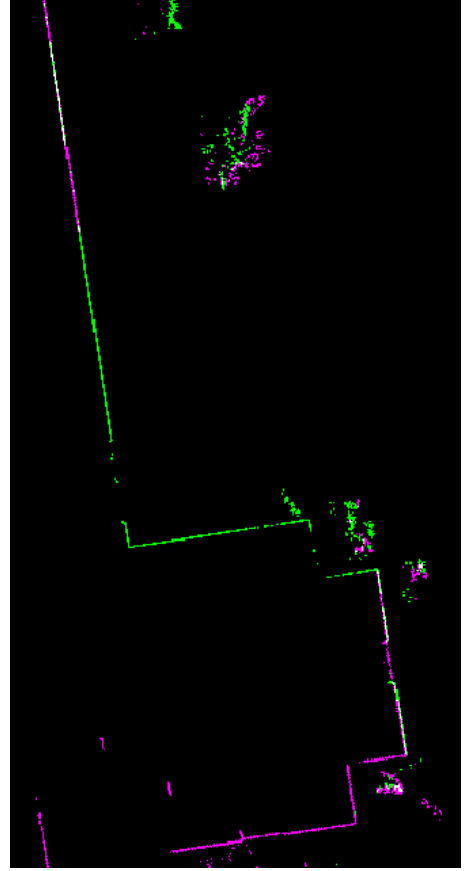
Figure 4. Zoomed registered cross section images using the estimated horizontal displacement and rotation